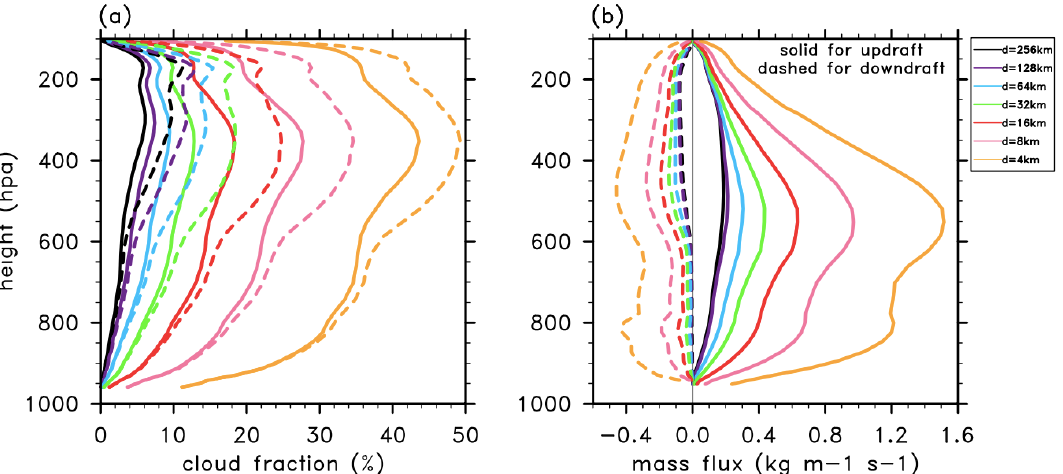
Figure 2. Profiles of ( a ) cloud fraction and ( b ) convective mass flux for different subdomain sizes. The solid lines in ( a ) consider updrafts only, the dashed lines consider both updrafts and downdrafts. The total and eddy vertical transport of MSE ( h = C p T + gz + Lq ) and specific humid-